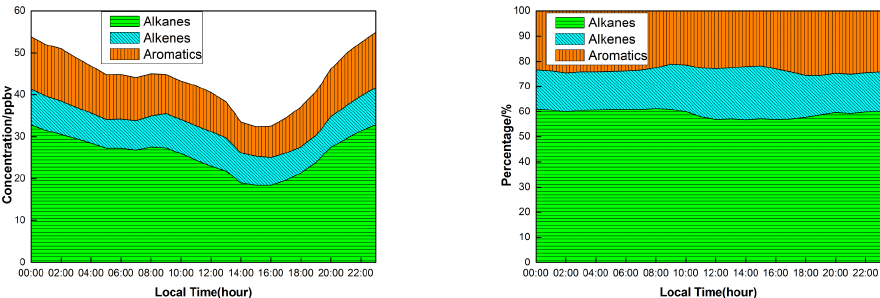
Figure 2. Diurnal variation of hourly averaged concentrations of three categories of VOCs inppbv and in fraction (from June 2011 to May 2012) at